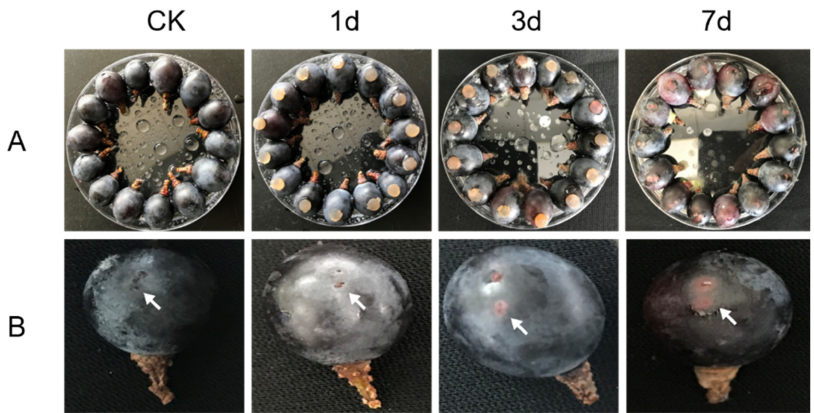
Figure 1. Symptom development in Vitis davidii Föex berries upon pathogen attack. ( A ) Uninfected berries at day zero were used as control samples (CK), an inoculation was made at day zero, and